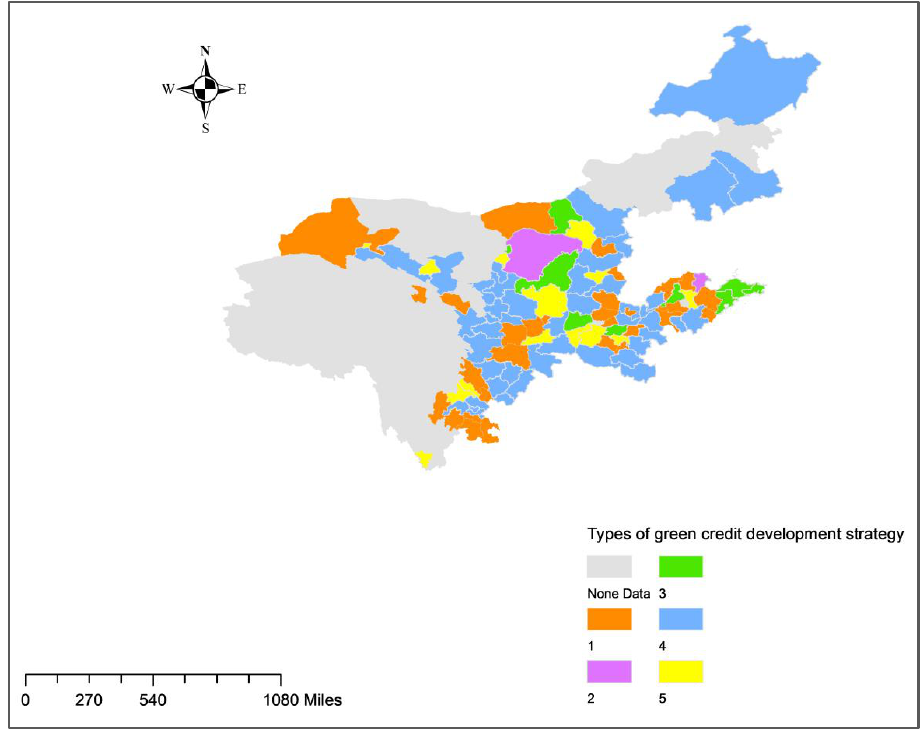
Figure 8. Green credit development pattern distribution.